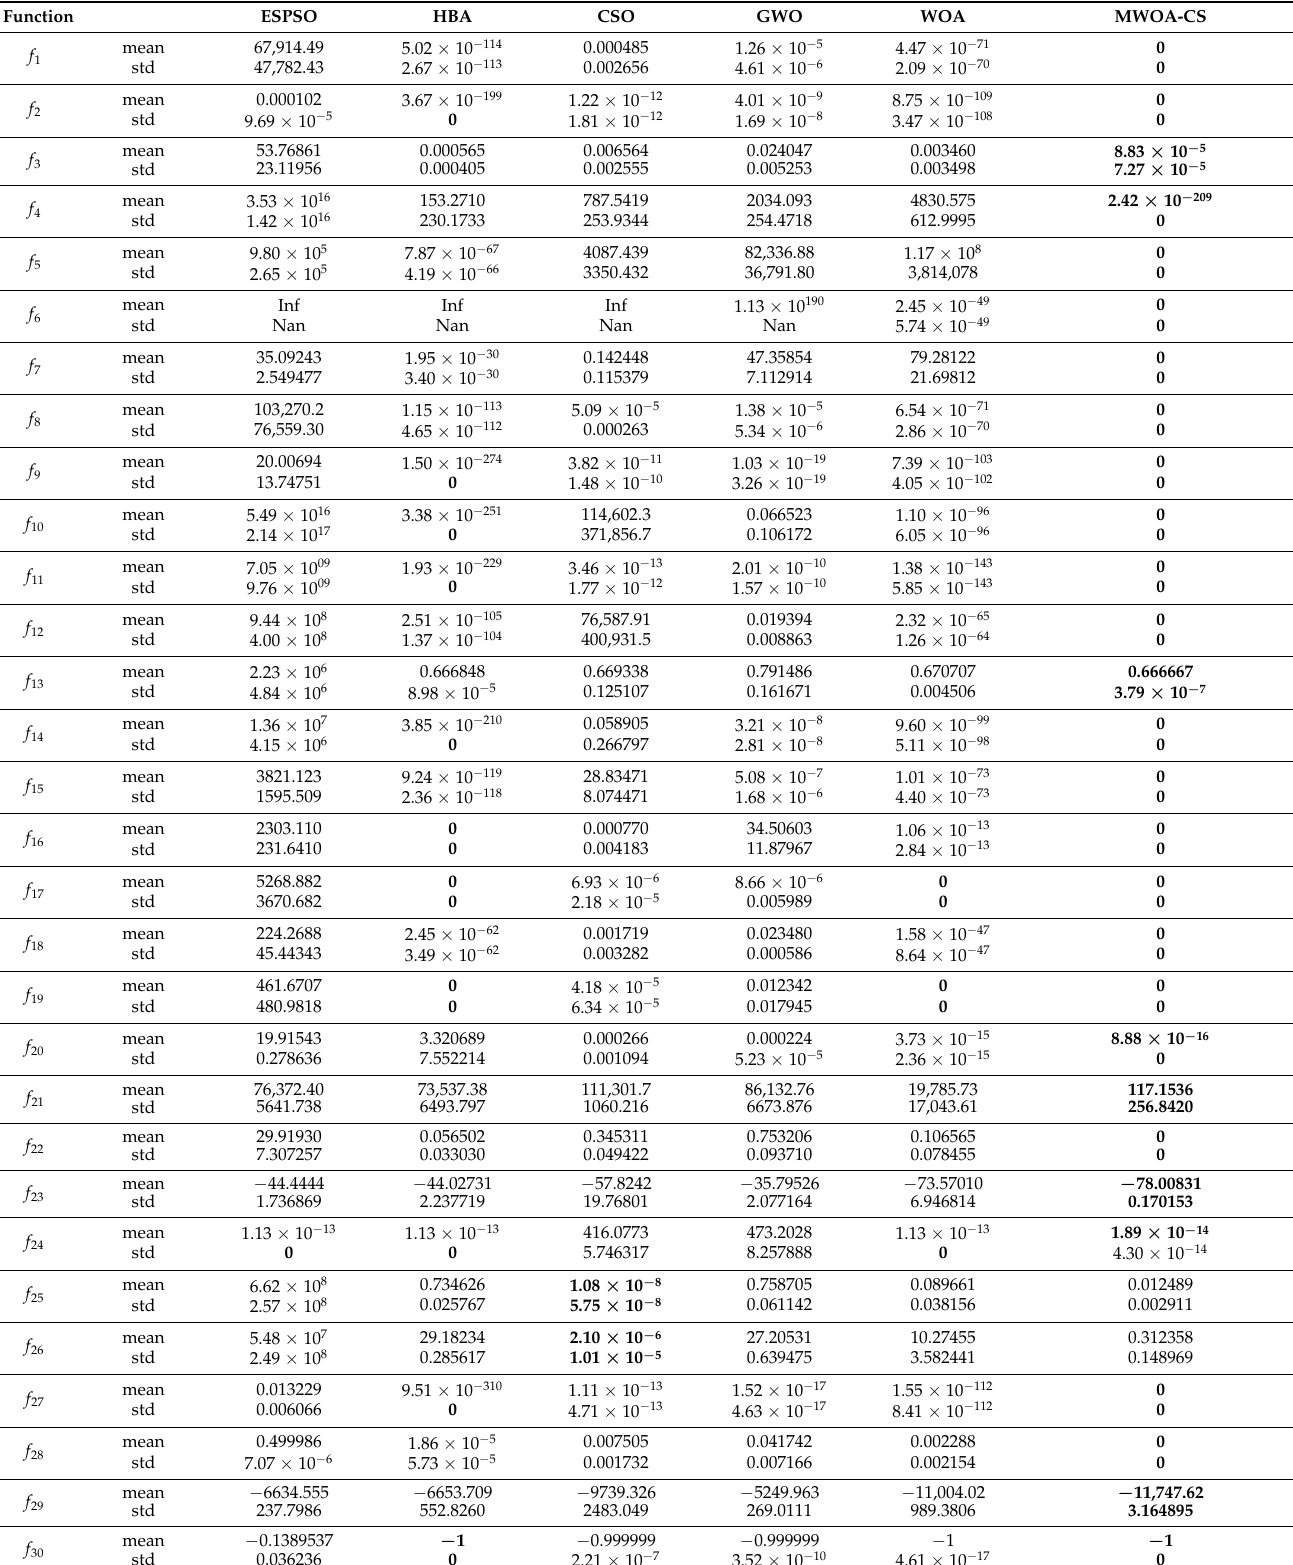
Table 3. Comparison results of algorithms for test problems with dim =